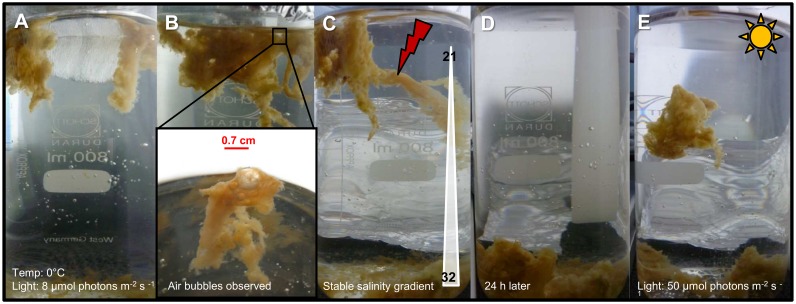
Buoyancy test.(A) A piece of ice with several attached filamentous algal aggregates was kept in a glass beaker at simulated in situ conditions. (B) Once the ice disappeared it was observed that air bubbles were trapped in the mucous matrix of the floating aggregates. (C) Despite the salinity gradient, one of the aggregates sank when the air bubbles were removed. (D) 24 h later all algal aggregates had sunk. (E) Only when increasing the light intensity, some of the algal aggregates were able to produce enough oxygen to regain buoyancy. Scale bar = 2 cm.